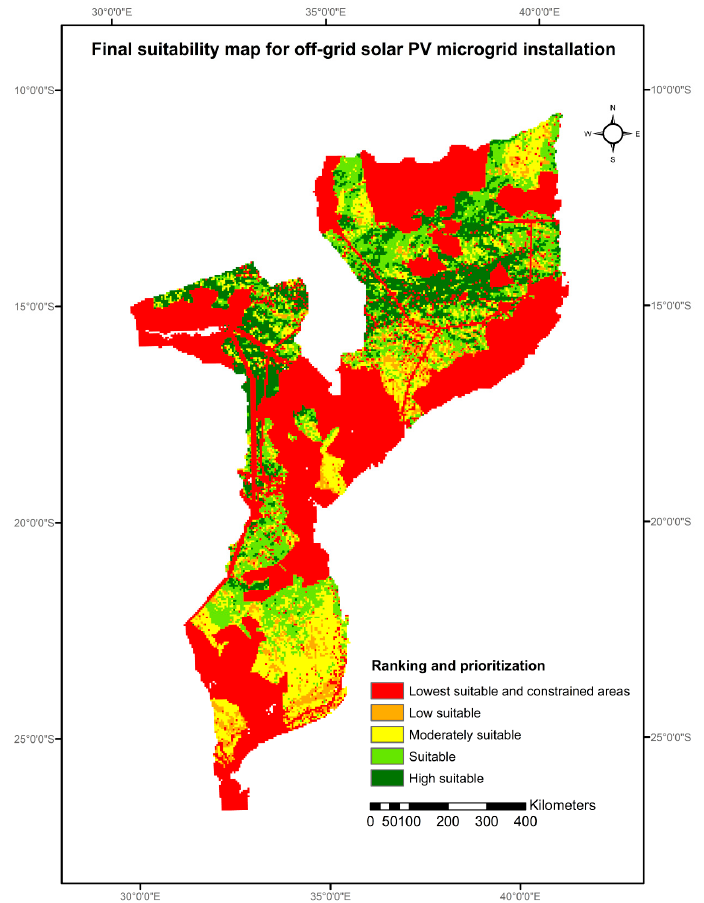
Figure 12. Final site suitability map for off-grid solar PV microgrid deployment.